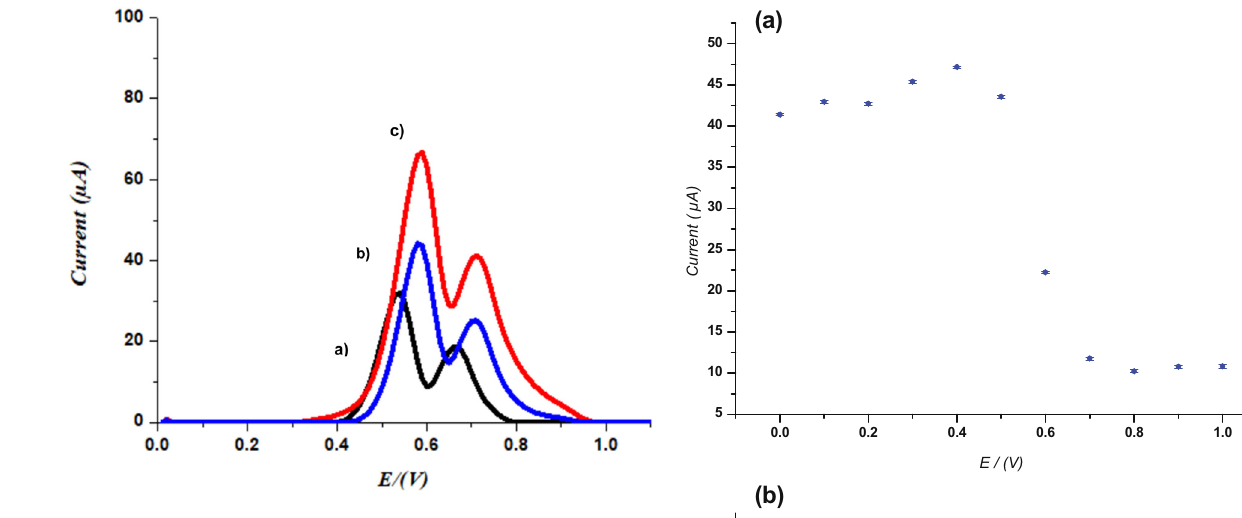
Figure 3: SWV of 1.0 × 10 − 4 M SUL at ( a ) bare PGE, ( b ) 1 mL:5.0 × 10 − 3 M ratio of GO/ β - CD modi fi ed PGE, ( c ) 2 mL:1.0 × 10 − 2 M ratio of GO/ β - CD modi fi ed PGE in BRB solution.